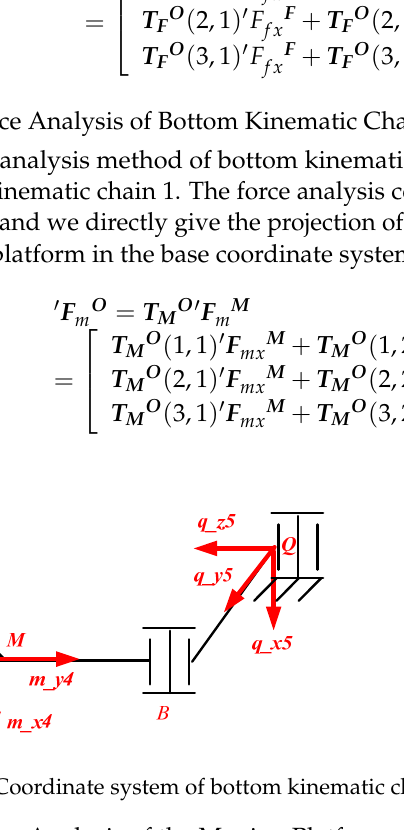
Table 2. Parameters of simulations.